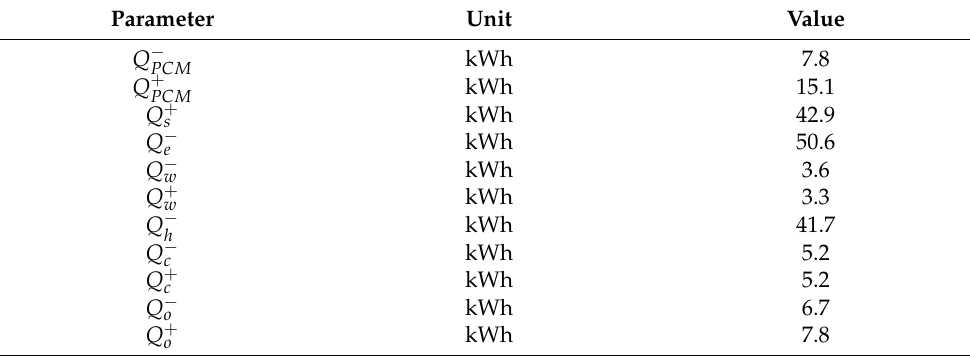
Figure 24. Variation of the LHTES and chiller heat transfer rates during the occupied period ( a ) and the percentage ratio of the heat transfer rates ( b ). Table 6. Summary of 24 h cycle heat values.